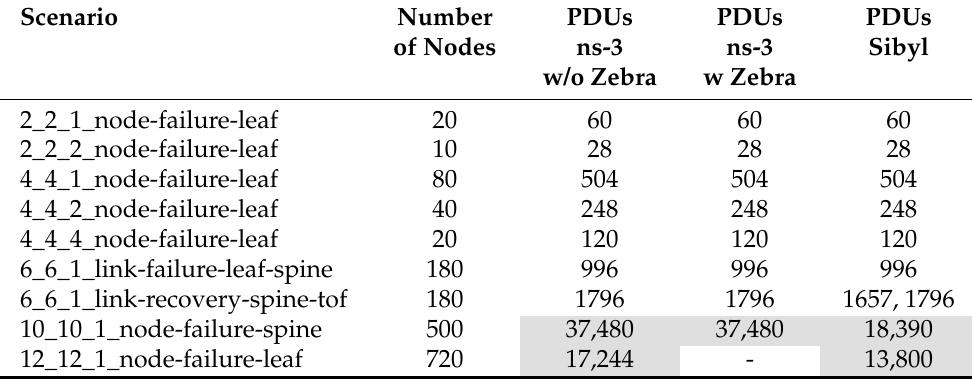
Table 1. Representative results for comparison against